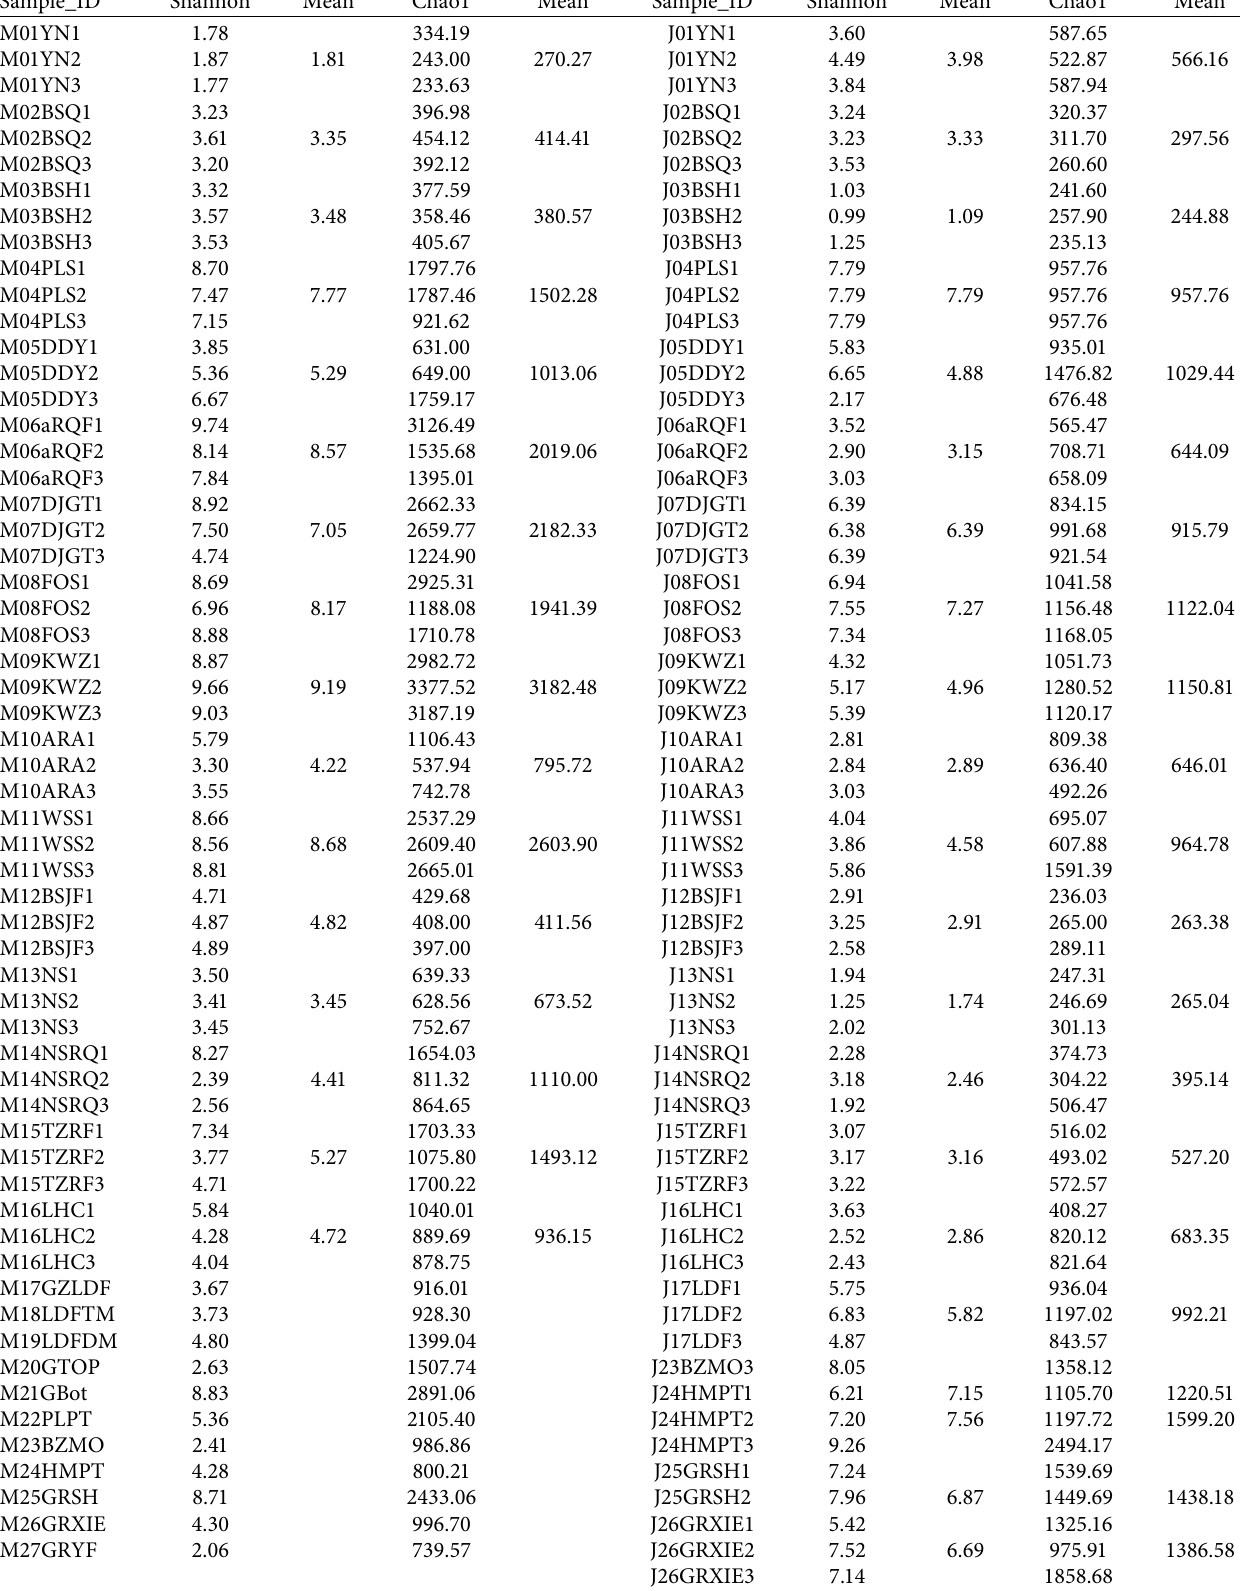
Table 2: Estimates of bacterial α -diversity in spring ( M ) and summer ( J )